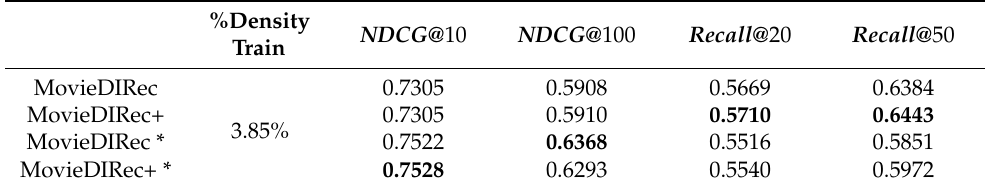
Table 3. Metric table of models that did train/test in a ratio of 80:20 without matching the density. %Density